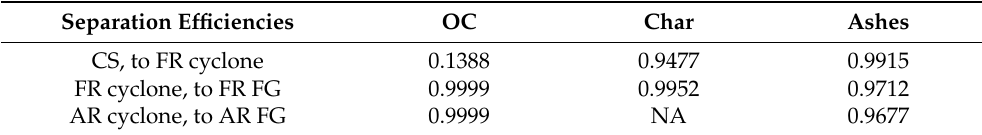
Table 4. Cyclone and CS separation